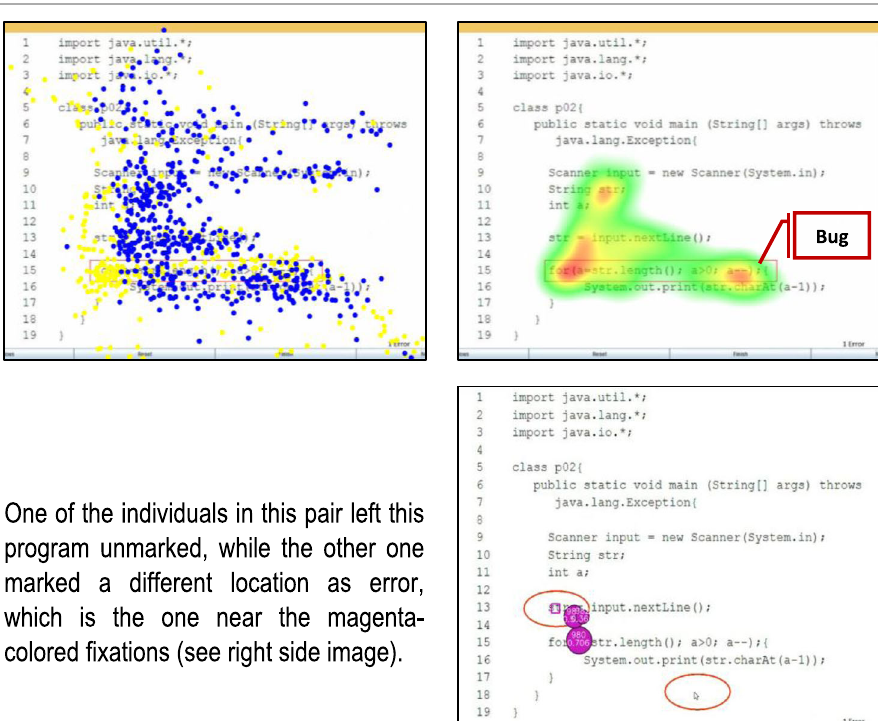
Fig. 7 An example of a case of “staring but not seeing”